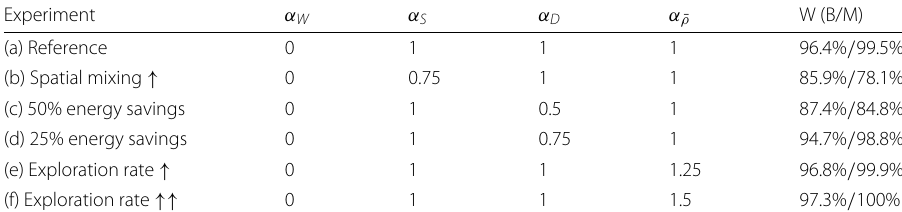
Table 1 Experiments performed. Column W indicates the relative gain of ( W 0 − W k )/ W 0 . The first value is for Barcelona (B) and the second for Madrid (M) Experiment α